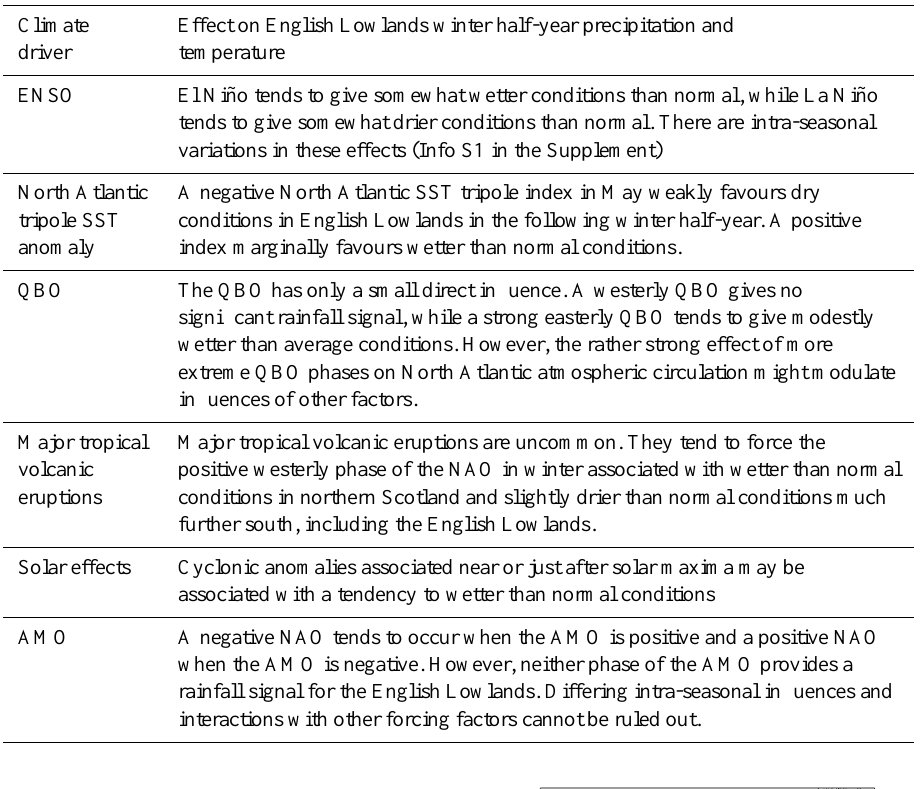
Table 3. Summary of remote drivers of English Lowlands rainfall. Only the influences on English Lowlands climate are summarised; effects elsewhere in UK may be larger or different.